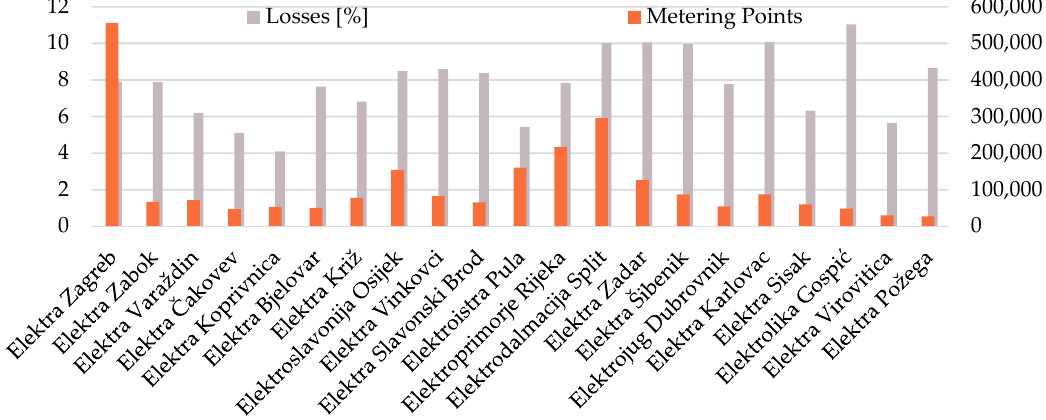
Figure 3. Number of metering points and grid losses for the 21 distribution areas of Croatian DSO [35].